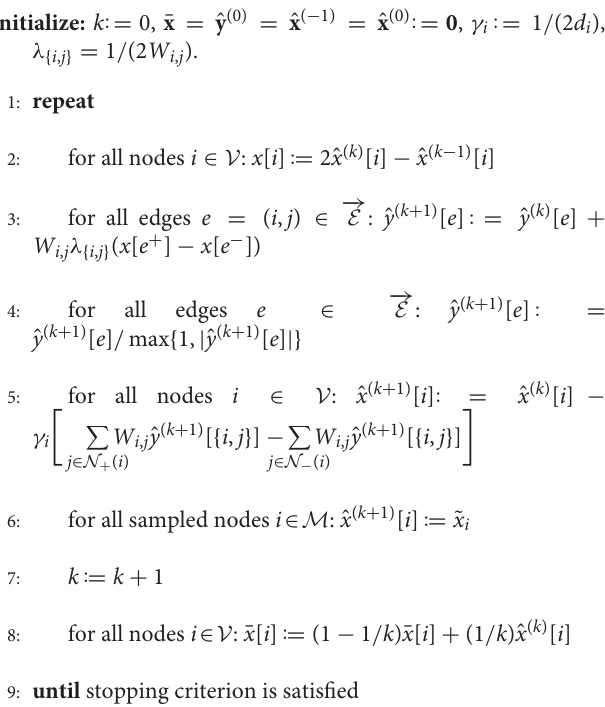
Algorithm 2 Sparse Label Propagation as Message Passing